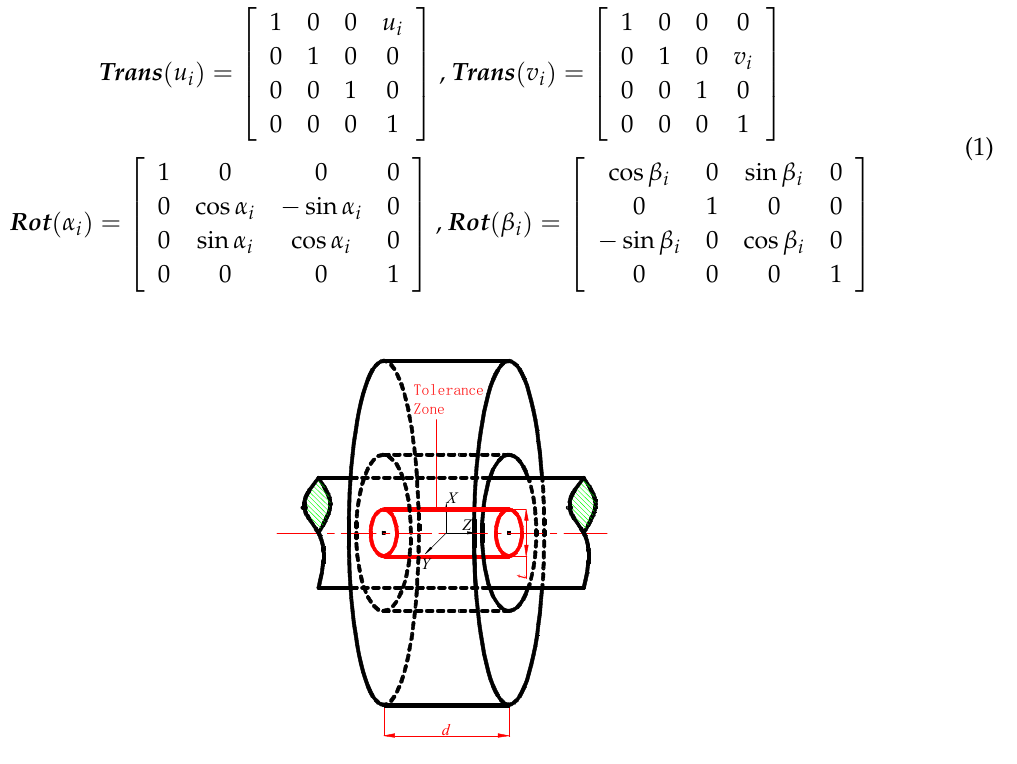
Figure 1. Shaft-hole fit and cylinder tolerance zone.